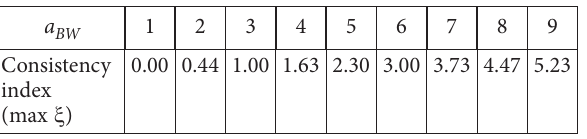
Table 2. The consistency index table for the BWM